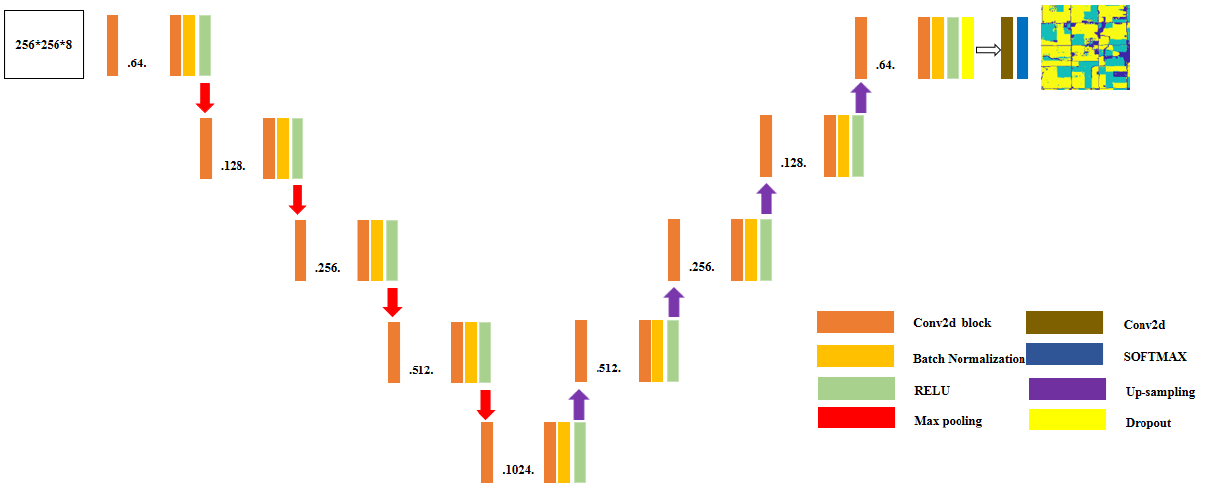
Figure 8. Proposed U-net network.